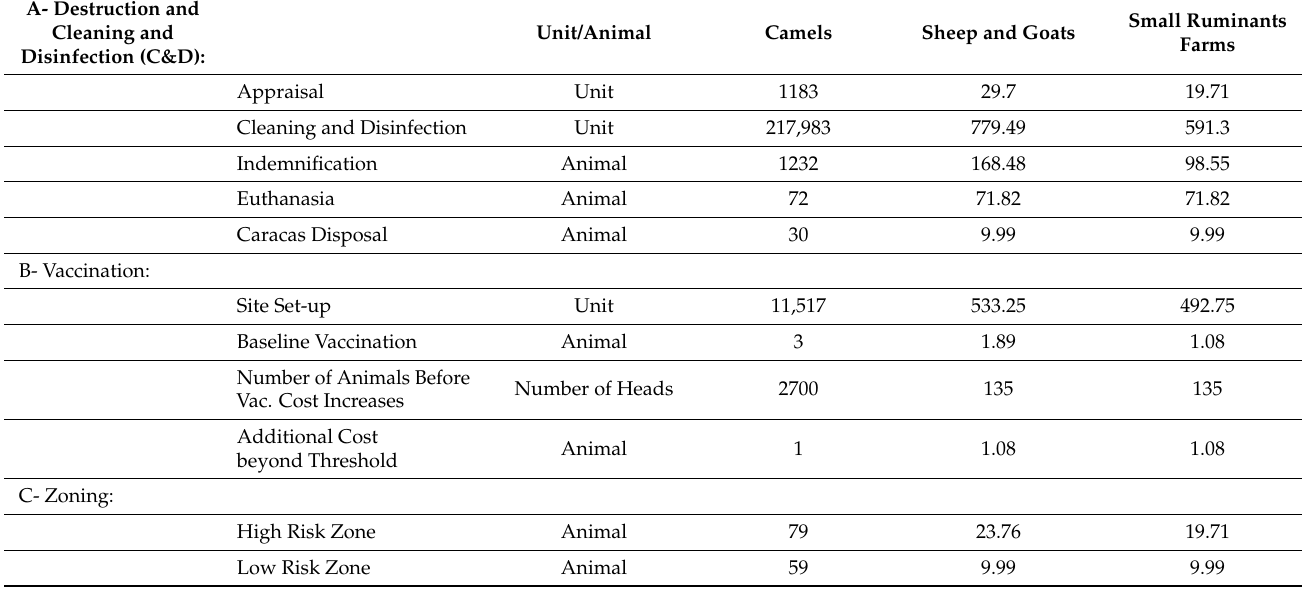
Table A1. Government direct cost parameters in US